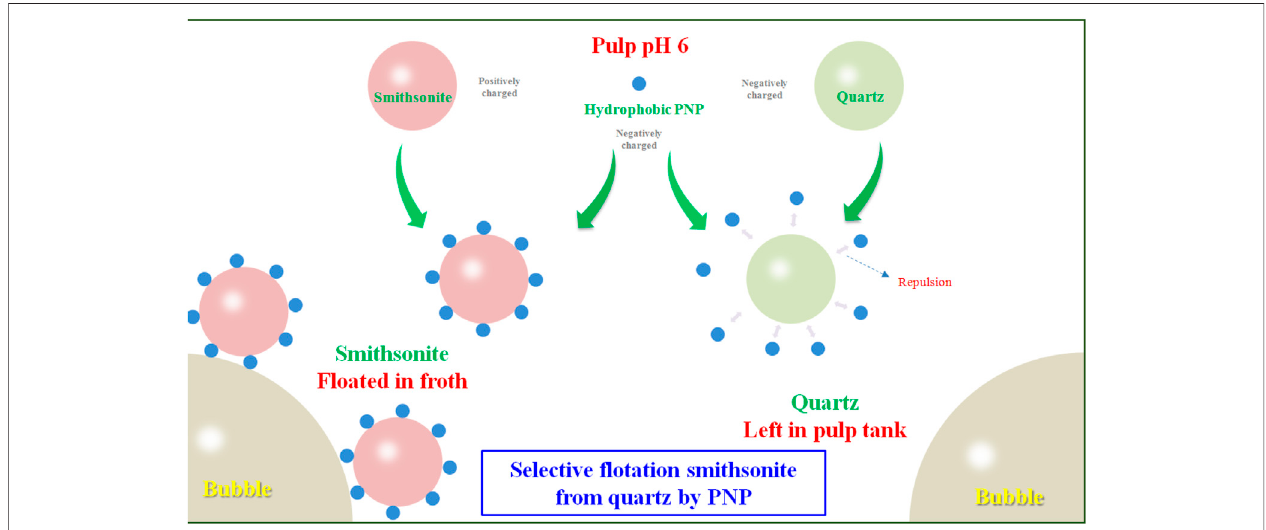
FIGURE 8 | Model schematic diagram for PNP fl otation separation smithsonite from